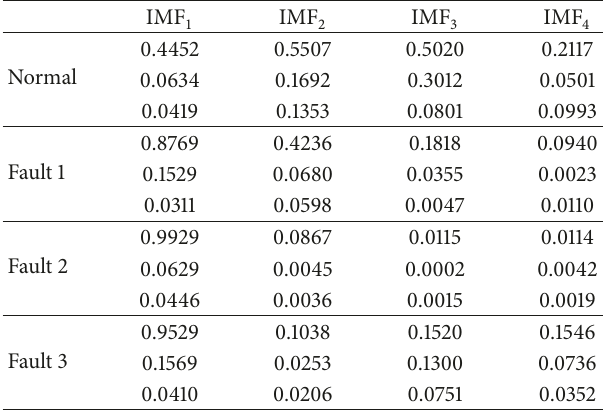
Table 1: Correlation coefficients between IMFs and the original signal in four